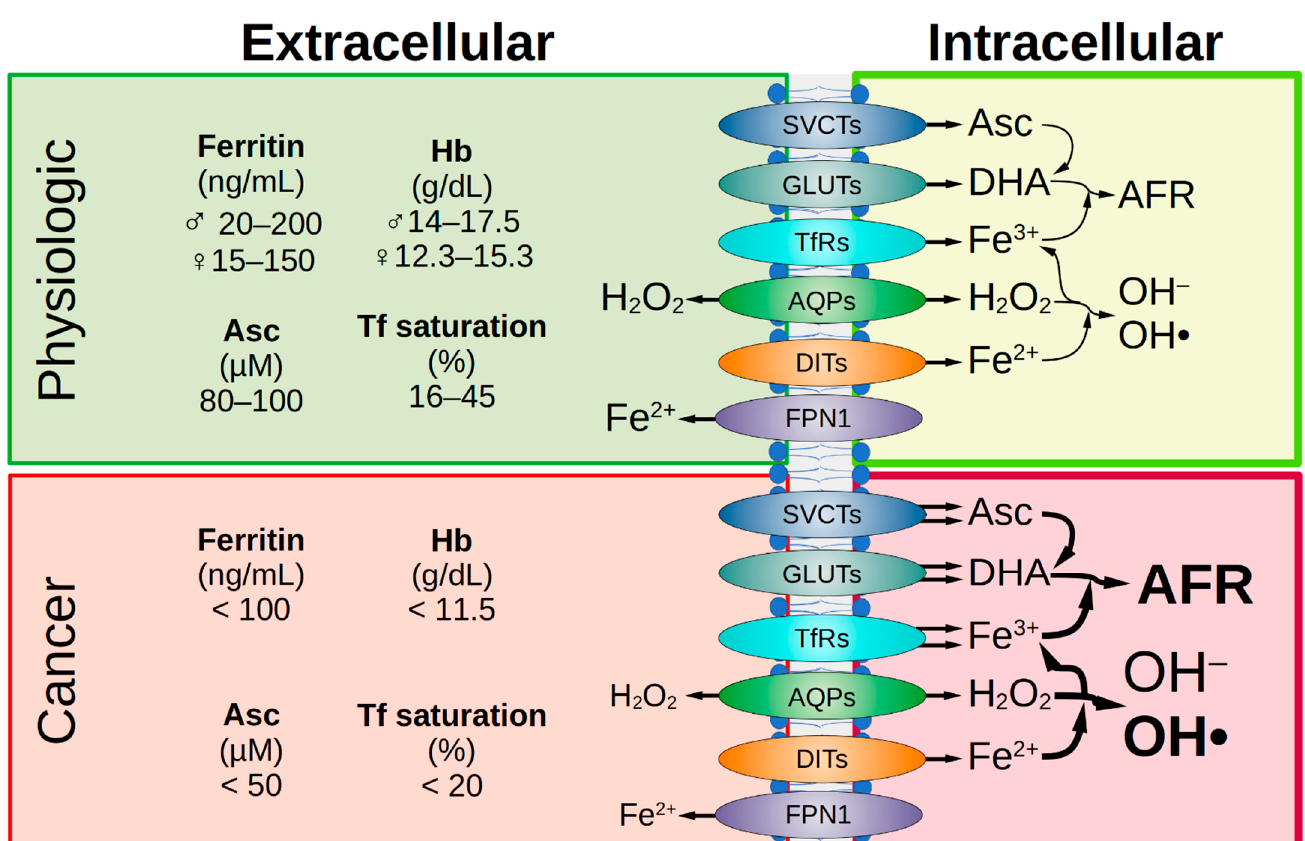
Figure 2. Comparison of healthy and malignant tissue. Under physiological conditions, iron status is represented by various extracellular parameters. The physiological ascorbate concentration is 80–100 µM. The transport of Asc, DHA, iron, and H 2 O 2 across the cell membrane is facilitated by various transport proteins and receptors. Intracellularly, under physiological conditions, the amount of labile iron is low, therefore the formation of the AFR and hydroxyl radicals is low. In tumor patients, a decrease in iron parameters and ascorbate concentration in the extracellular space is often observed. If SVCT2 expression is high in the malignant cells, they are sensitive to ascorbate treatment and this is favorable for treatment success. Due to the frequently elevated expression of various GLUTs in tumor cells, there is increased uptake of DHA and enhanced formation of AFR. This is favored by an elevated pool of intracellular labile iron in cancer cells due to enhanced uptake via TfR as well as decreased iron e ffl ux due to reduced FPN1 expression. This leads to supraphysiolog- ical H 2 O 2 concentrations in cancer cells. Under pharmacologic ascorbate treatment (plasma levels up to 20 mM), H 2 O 2 concentration is massively increased and causes cellular damage. AFR, ascor- bate free radical; AQP, aquaporin; Asc, ascorbate; DHA, dehydroascorbic acid; DIT, divalent iron transporter; FPN1, ferroportin 1; GLUT, glucose transporter; Hb, hemoglobin; SVCT, sodium-de- pendent vitamin C transporter; Tf, transferrin; TfR, Tf receptor.